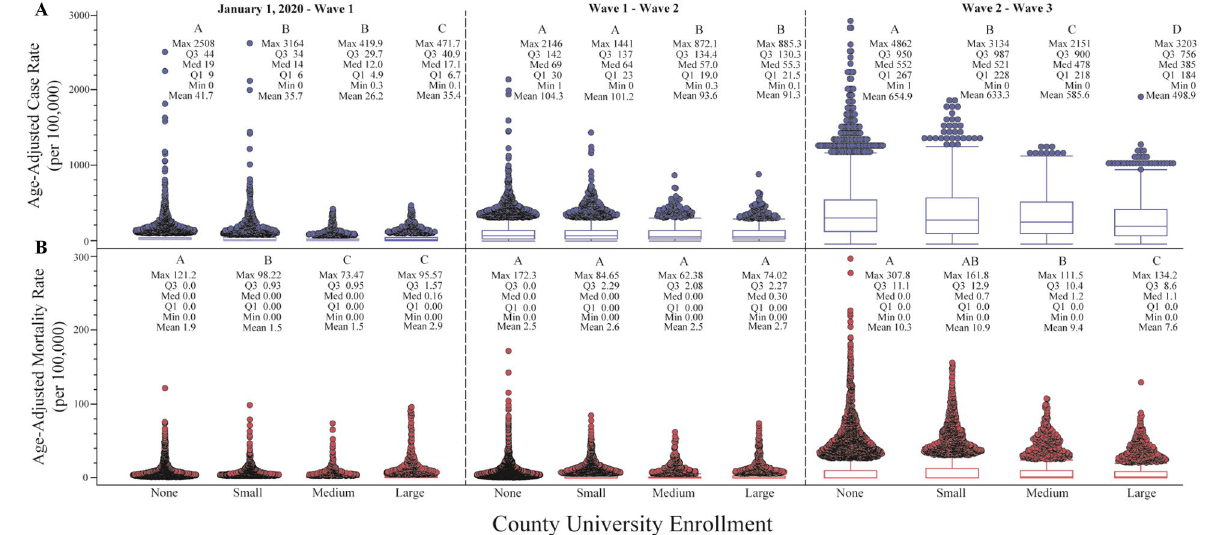
Figure 5. Box plot of mean SARS-CoV-2 age-adjusted case ( A ) and mortality ( B ) rates broken down by each significant outbreak “wave” period. Wave periods were determined by natural breaks in distinctive peaks, based on cases in the United States cases between January 1, 2020 and March 30, 2021. Unique letters, arranged in descending order (highest mean value = A and so on), indicate statistically different groups (case and mortality rates, respectively; assessed by Student’s t-test, p value ≤ 0.05). Individual circles represent outlier counties.